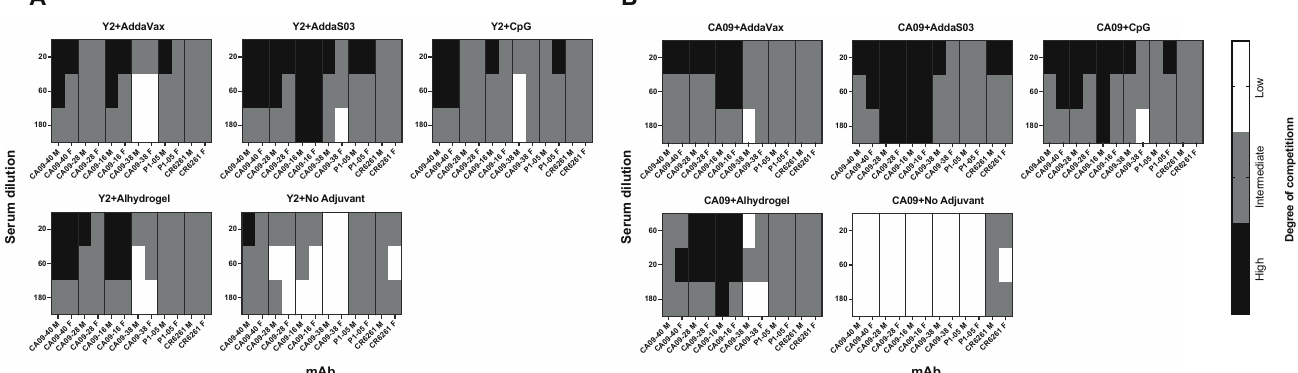
Figure 4. Epitope mapping of d56 sera against the CA09 HA from Y2- and CA09 HA-immunized mice. Competition ELISAs were used to determine the HA epitopes bound by mouse serum for Y2- and CA09 HA-immunized mice. Sera from pooled mice were competed with human mAbs specifically against distinct HA head and stem epitopes. The degree of competition for serially diluted mouse sera with the indicated human mAbs is shown as a heat map for final serum dilutions of 1:20, 1:60, and 1:180 for these groups for ( A ) Y2-immunized mice and ( B ) CA09 HA-immunized mice. M, male pooled serum; F, female pooled serum.